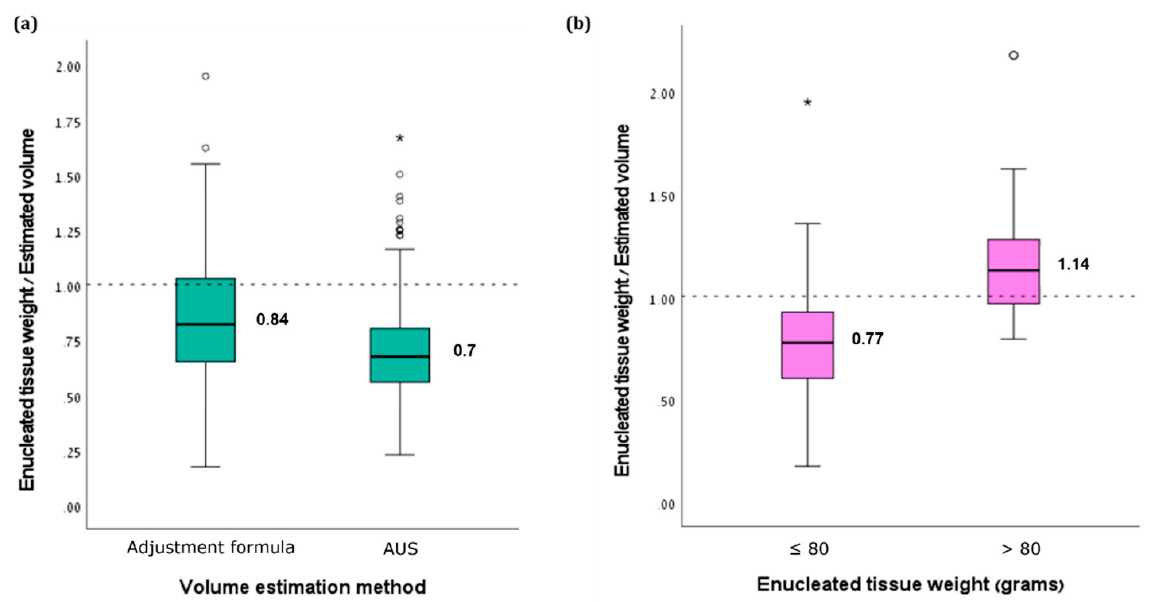
Figure 1. Box-and-whisker plot showing the ratios of enucleated tissue weights and estimated volumes by ( a ) AUS and adjustment formula and by ( b ) adjustment formula among patients with tissue weights above and below 80 g. The dashed horizontal line at level 1.0 represents 100% accuracy. * Represents outliners.